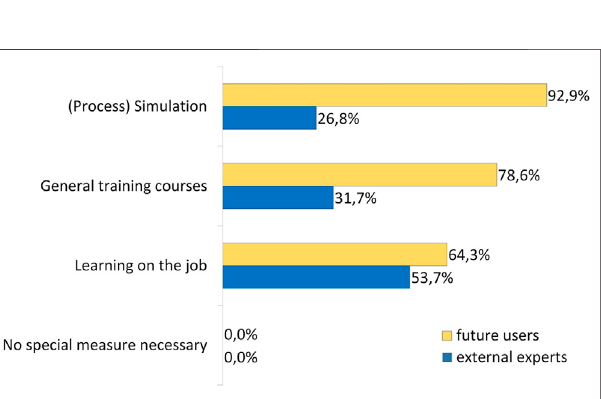
FIGURE 6 | Job pro fi le change: from operator to supervisor (Colla, 2019, permission obtained).